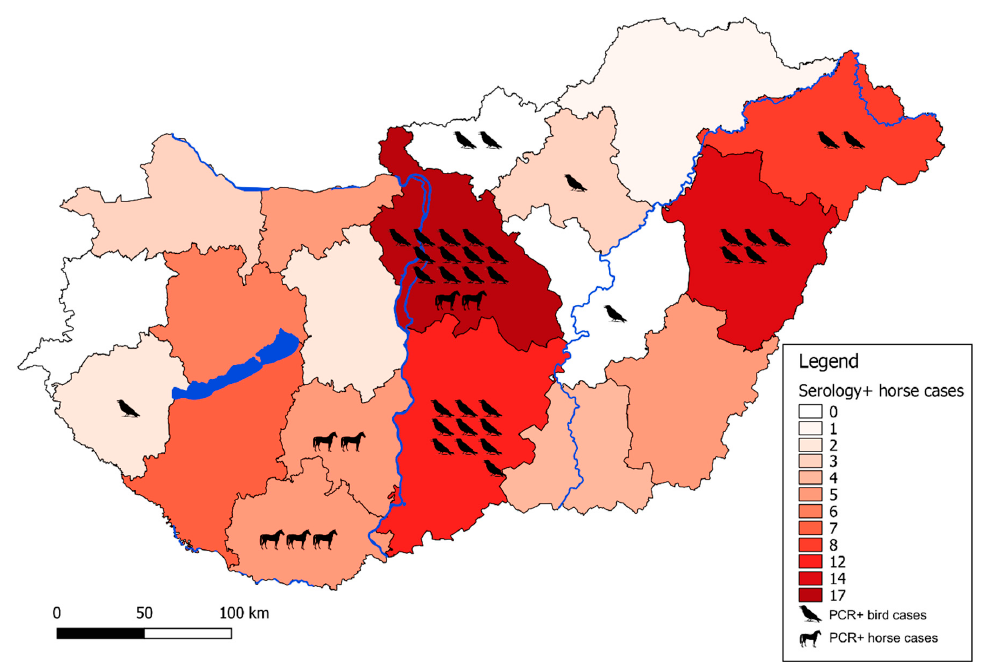
Figure 3. Geographical distribution of enzootic WNV cases. Color background of each county represents the number of IgM seropositive horses in that specific region from 2018 as annotated on the sidebar. Individual PCR-positive animal cases are indicated with respective pictograms to each case in that specific region.